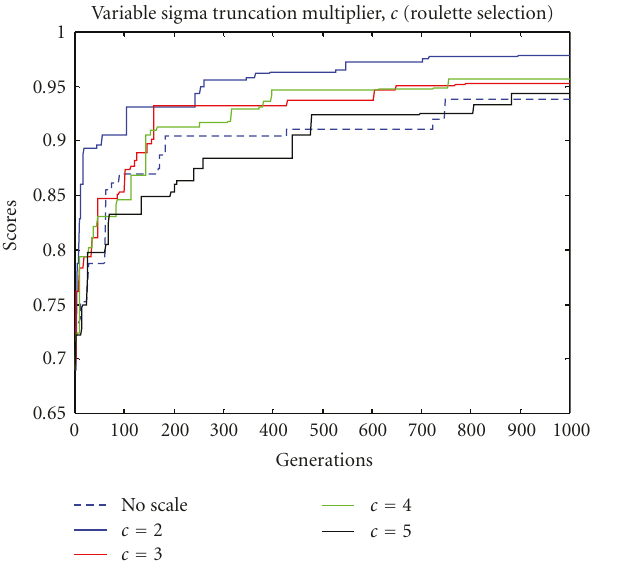
BS-placement after 1000 generations (uniform), 91 . 99% coverage